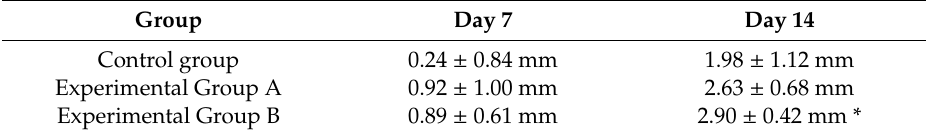
Table 2. The distance of tooth movement. Reproduced with permission from Kim, S. G. [43].